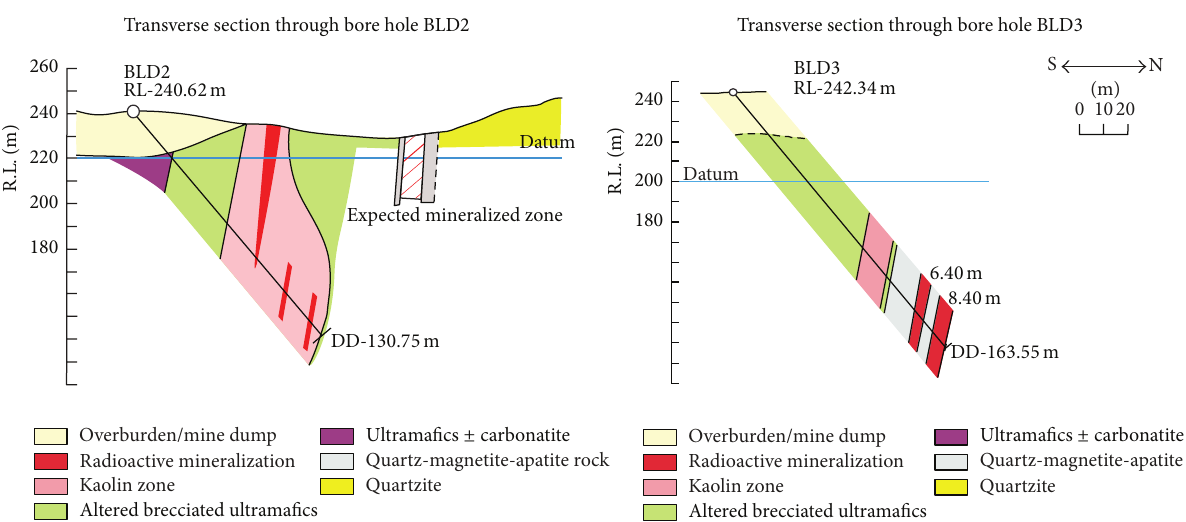
200 m and 450 m. Apparent current density cross-section depicts both of the structures between stations 150 m and 250 m, and 410 m and 520 m and shows that they are dipping structures. Radiometric data shows high radioactivity in the southern side of the profile compared to the northern side, with peak value of total radiation and gamma activity (140 counts/100 sec and 28 𝜇 R/h, resp.) found above the station 250 m.